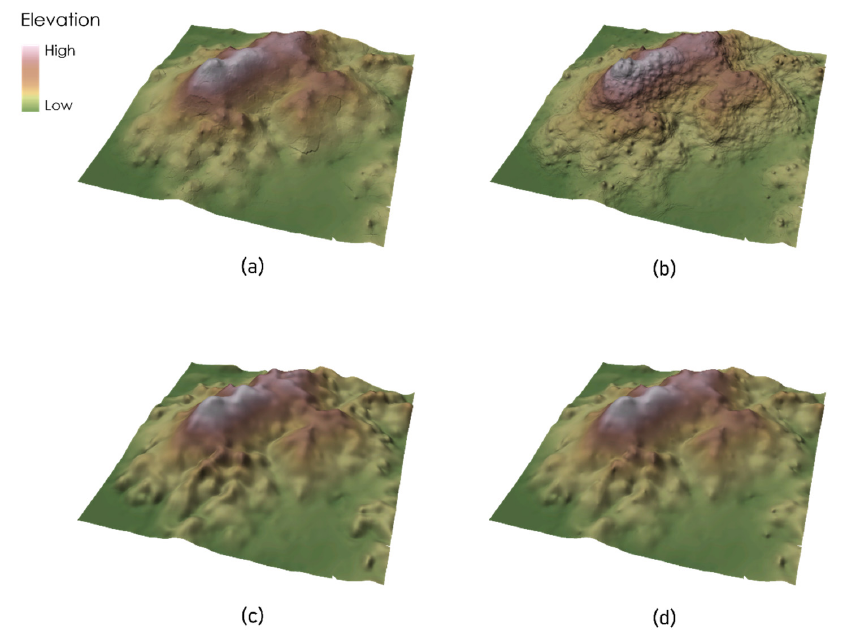
Figure 2. Interpolation of a DEM: ( a ) Ordinary Kriging (spherical variogram); ( b ) IDW; ( c ) Regular- ized Spline; ( d ) Tension Spline.